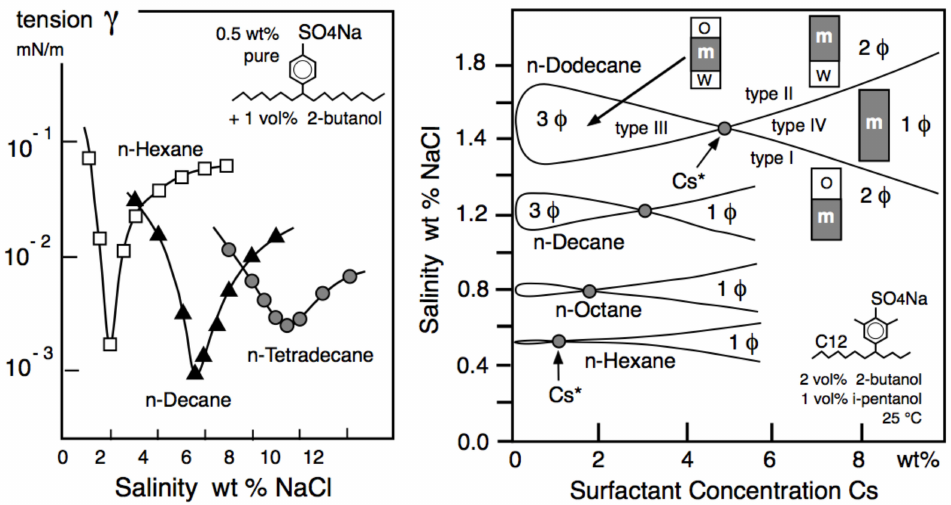
Figure 8. E ff ects of two formulation variables (water salinity and oil alkane carbon number (ACN)) on interfacial tension with a minimum at optimum ( left ) and on the best solubilization in a fish diagram as the surfactant concentration Cs* minimum to attain a single-phase region ( right ).